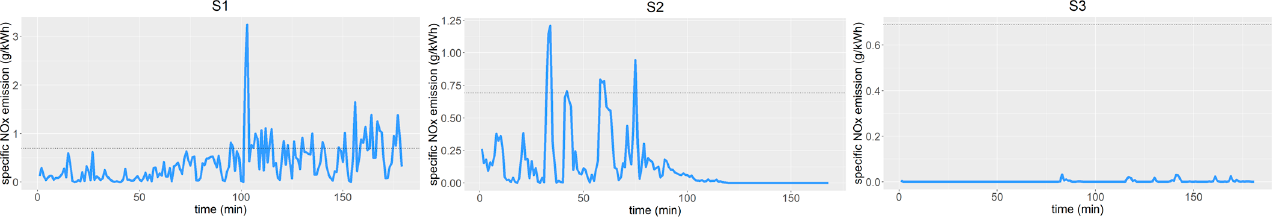
Figure 5. Time series of speci fi c NOx emissions (based on one-minute interval average). The horizontal do tt ed line indicates the threshold value of 0.69 g/kWh.